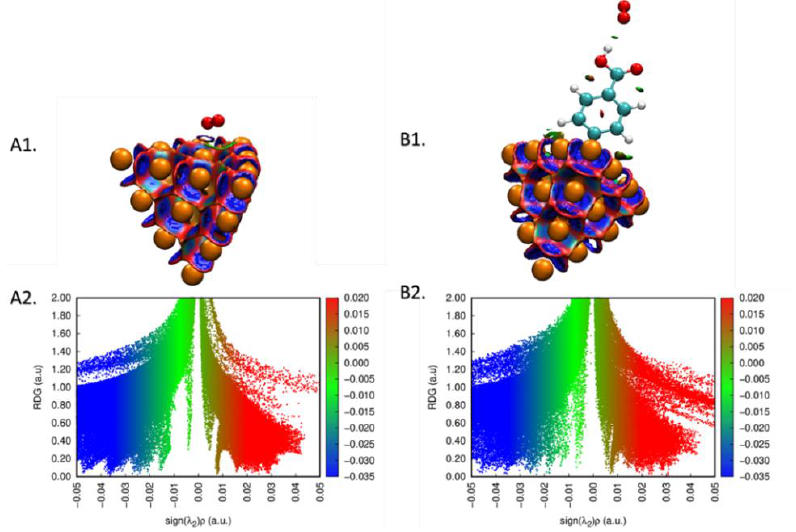
Figure 8. (A1 , B1 ) Noncovalent interaction surfaces and the plot of ( A2 , B2 ) reduced density gradient (RDG) vs. sign(λ)ρ for the interaction of oxygen with bare and Au20-CP cluster. The bond dissociation energy (BDE) [25,27,40,42], reported in Tables 3 and 4, was used as an indirect measure of the stability of the grafted layers. In comparison with